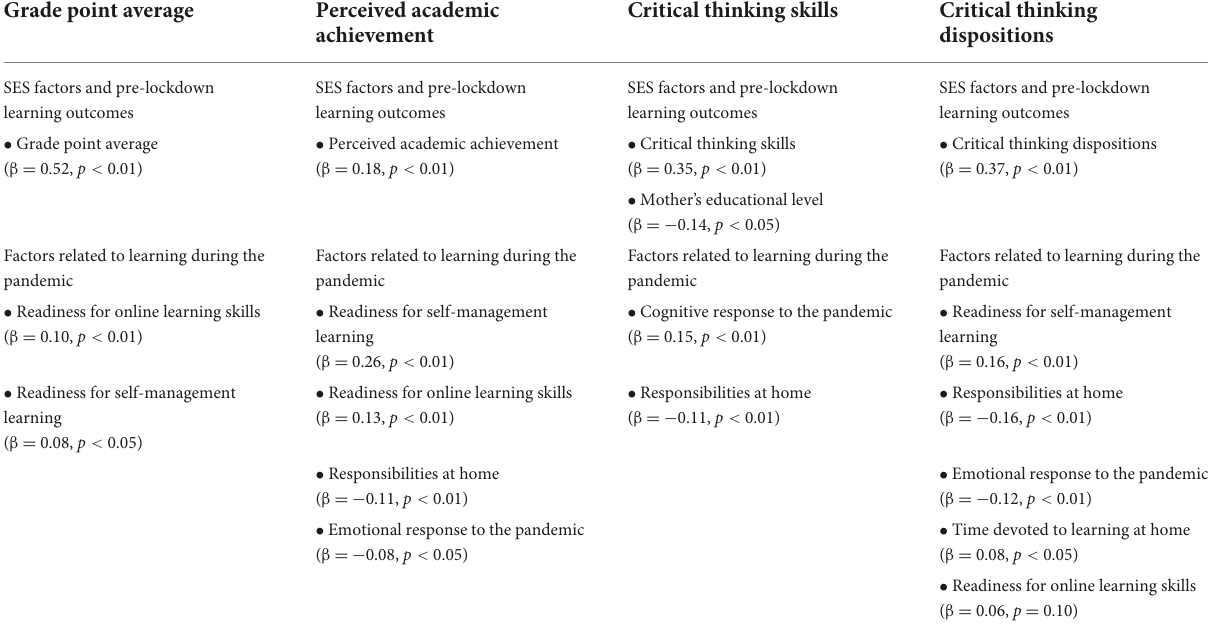
TABLE 2 Standardized regression coefficients from the final trimmed hierarchical linear regression models with socioeconomic status (SES) factors and pre-lockdown learning outcomes in the first step, and the potential learning-related factors that were significantly identified by the separated models as the second